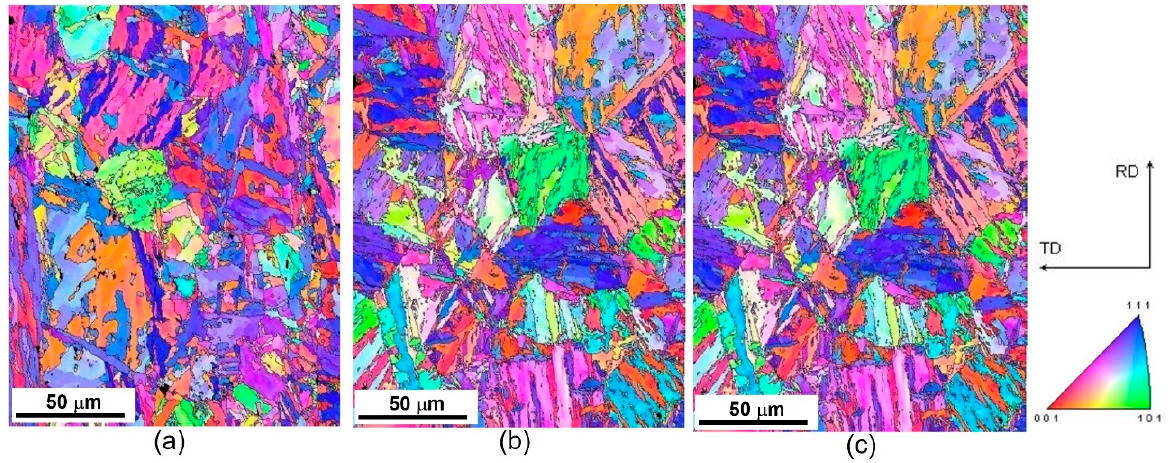
Figure 9. OIM analysis ( a ) M330-300 ( b ) M390-300 y ( c )